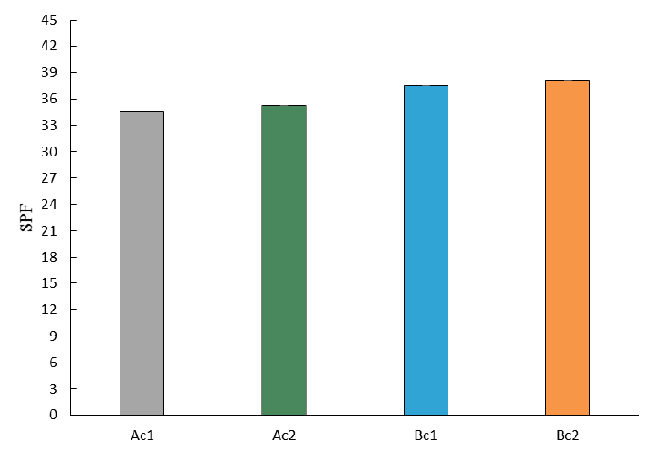
Figure 2. Sun protection factor (SPF) values of formulations Ac1, Ac2, Bc1, and Bc2 calculated using the BASF Sunscreen